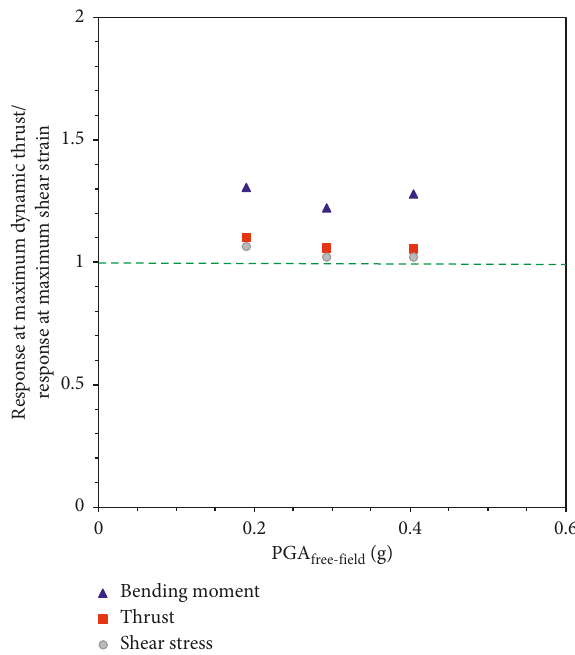
Figure 16: Ratio of extracted maximum responses of tunnel at time step of maximum thrust and maximum shear strain.